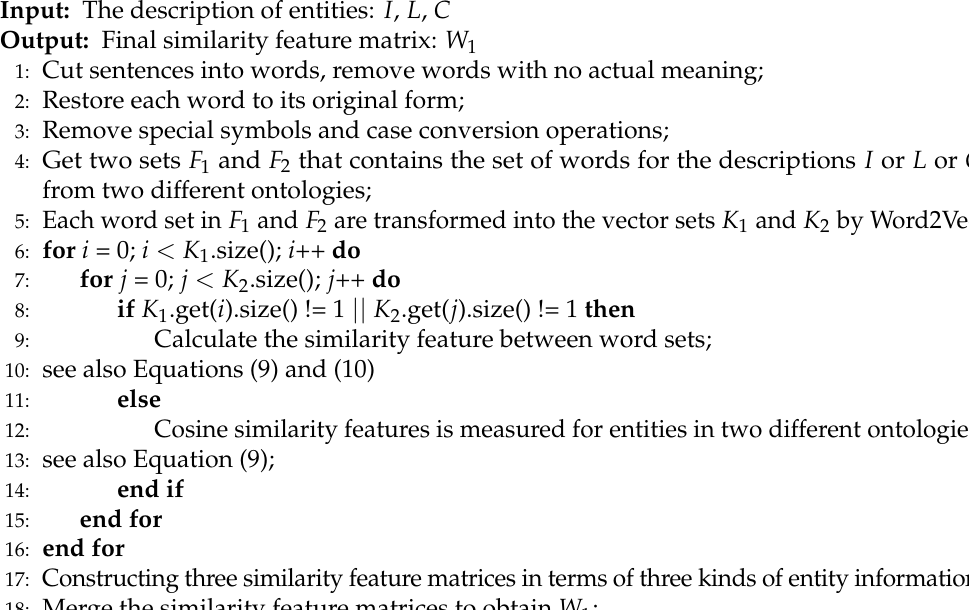
Algorithm 1 Context-based ANN Ontology Matching